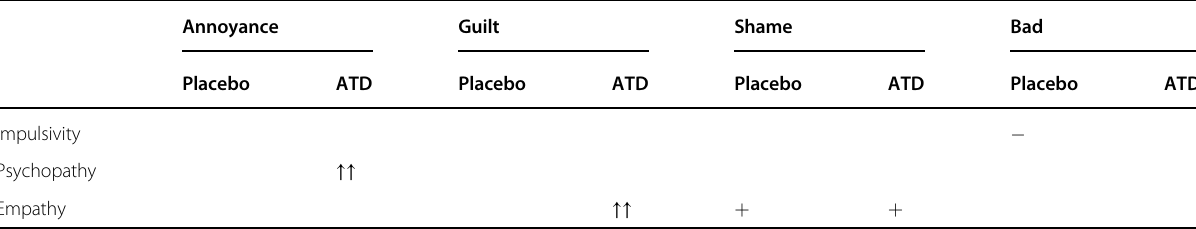
Arrows ( ↑↑ ) indicate a signi fi cant enhancement of the emotion by ATD at high levels of the personality trait shown; Plus sign ( + ) indicates a signi fi cant positive relationship between the personality trait and the emotion that was not signi fi cantly modulated by ATD; Minus sign ( − ) likewise indicates a signi fi cant negative relationship. Emotions are collapsed across agency and